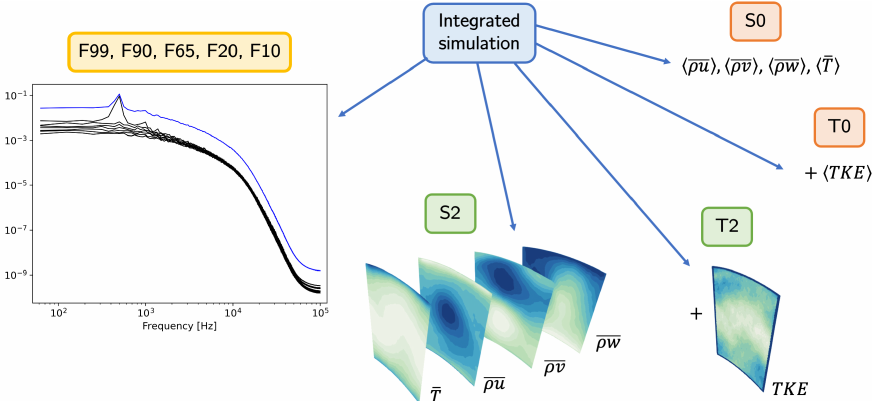
corresponds to the temporal average and •